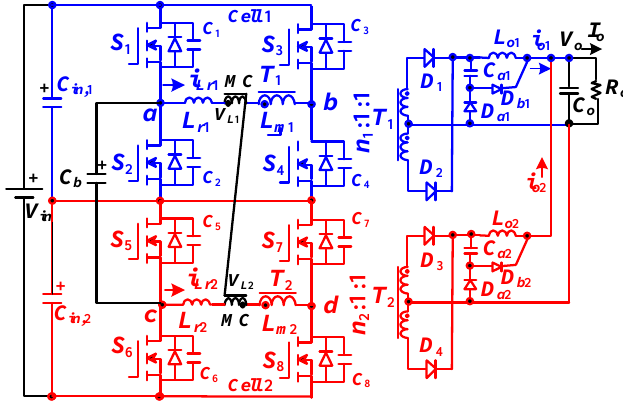
Figure 2. Circuit configuration of the studied converter.